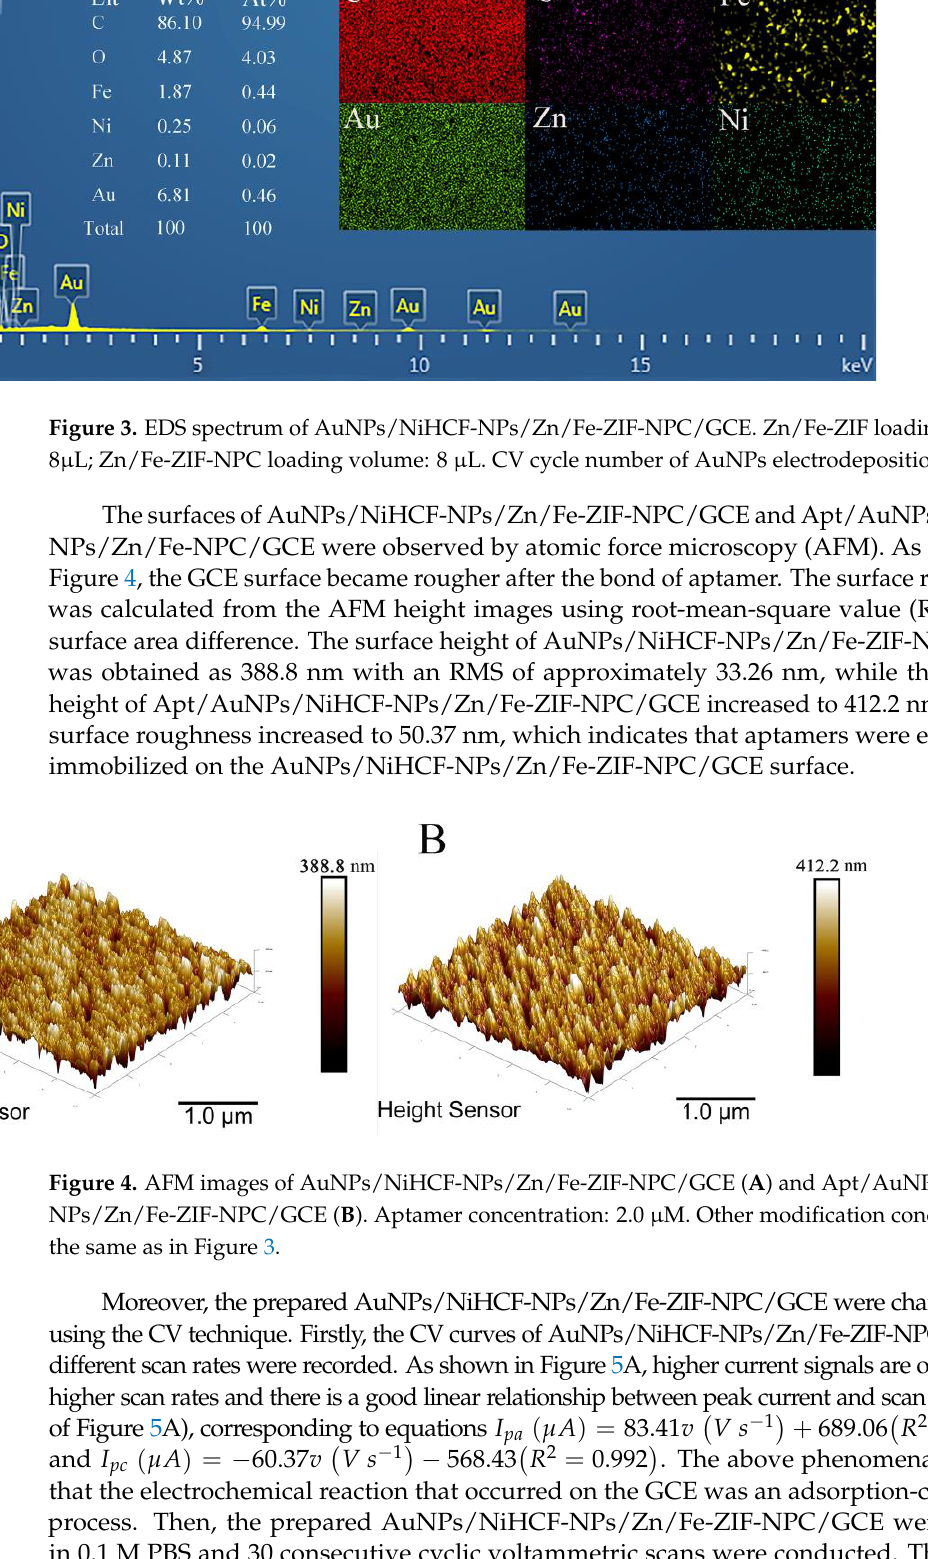
Figure 5. ( A ) CV curves of AuNPs/NiHCF-NPs/Zn/Fe-ZIF-NPC/GCE in 0.1 M PBS at various scan rates (from the inside to out: 0.02, 0.05, 0.10, 0.15, 0.20, 0.25 and 0.30 V s −1 ), (Inset: the relationship between the peak current and scan rate), ( B ) CV curves of AuNPs/NiHCF-NPs/Zn/Fe-ZIF- NPC/GCE in 0.1 M PBS at 0.05 V s −1 . The modification conditions are the same as in Figure 3. 3.3. Electrochemical Behaviors of Different GCEs Firstly, the electrochemical behavior of different modified GCEs during the aptasen- sor preparation processes was investigated by CV in 0.1 M PBS (pH = 7.0). As shown in Figure 6A,B, no redox peak appeared on bare GCE (curve g). However, a pair of distinct redox peaks appeared on NiHCF-NPs/GCE (curve a) with the oxidation peak current ( I pa ) and reduction peak current ( I pc ) of 10.89 μA and 6.65 μA. This pair of redox peaks was caused by the electron transfer between Fe 3+ and Fe 2+ in NiHCF-NPs [32]. After modifica- tion with Zn/Fe-ZIF-NPC (curve b), the I pa and I pc on NiHCF-NPs/Zn/Fe-ZIF-NPC/GCE increased to 33.42 μA and 28.62 μA, respectively, which were significantly higher than